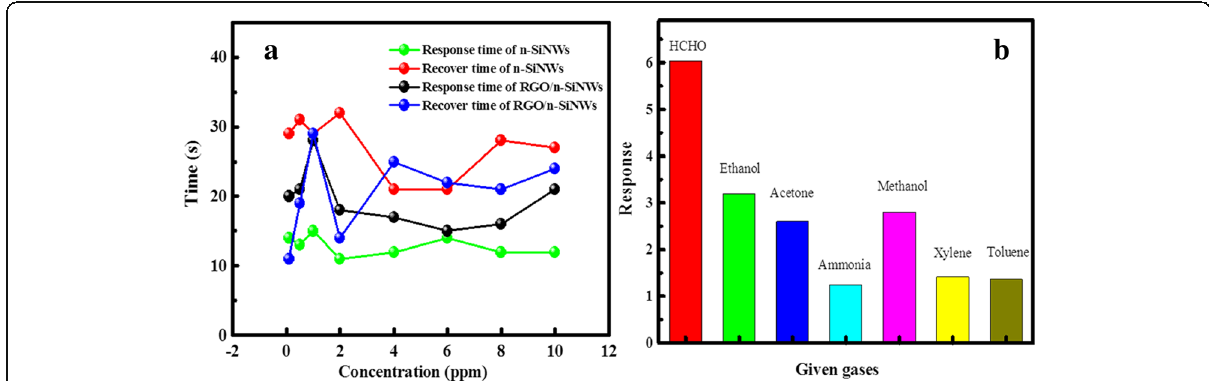
Fig. 4 a Response and recovery time of n-SiNWs and RGO@n-SiNWs to 0.1 ppm HCHO. b The response of n-SiNWs and RGO@n-SiNWs for seven types of common VOCs (10 ppm) at 300